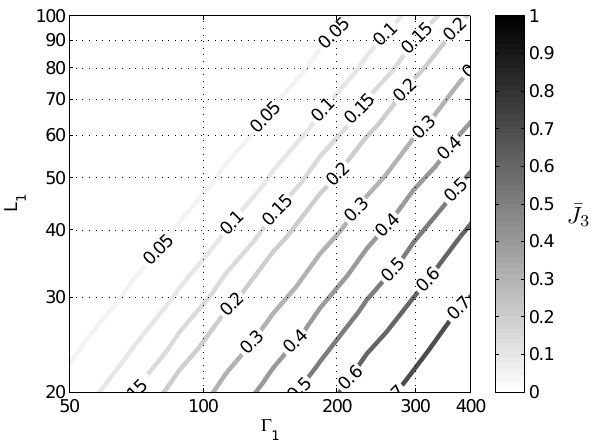
Fig. 2. Contour plot of modeled peak ¯ J 3 (0.05–0.70) as a function of measured ranges in the dimensionless cluster scavenging parameter L 1 and dimensionless cluster growth parameter 0 1 for the MILA- GRO campaign (Tecamac). ¯ J 3 is equal to the survival probability of a nucleated particle growing to the detection limit (3nm).